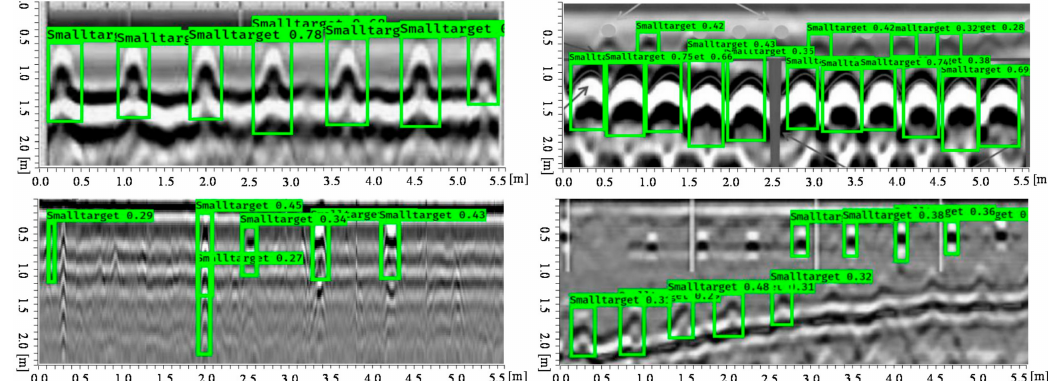
Figure 13. Pattern recognition of densely distributed reinforced concrete